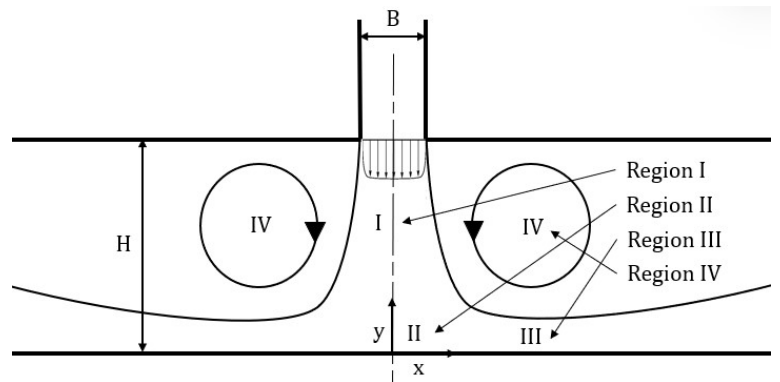
Figure 1. Geometry of a 2D confined slot impinging